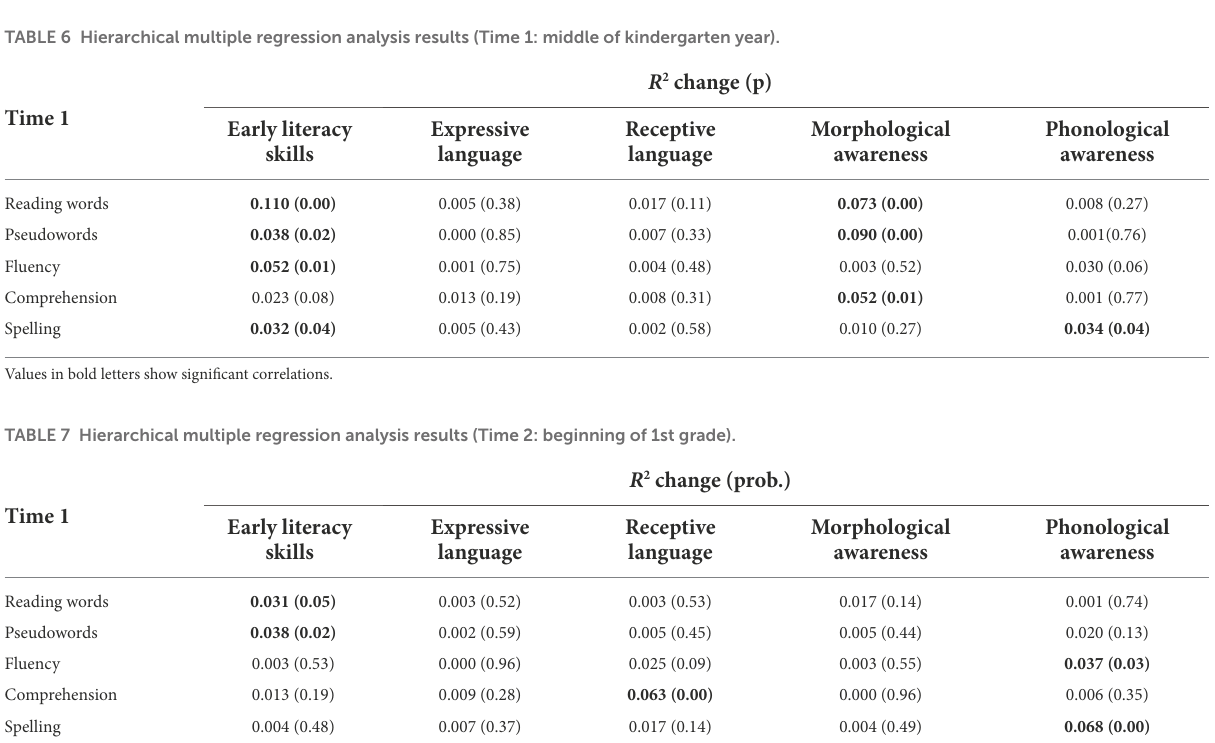
TABLE 6 Hierarchical multiple regression analysis results (Time 1: middle of kindergarten year).